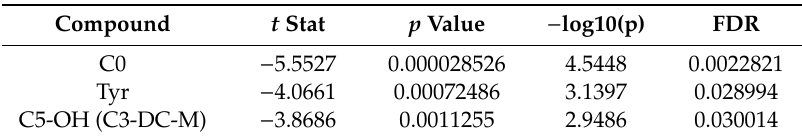
Table 2. Important features identified by t -test: Carnitine (free) (C0), hydroxyvalerylcarnitine